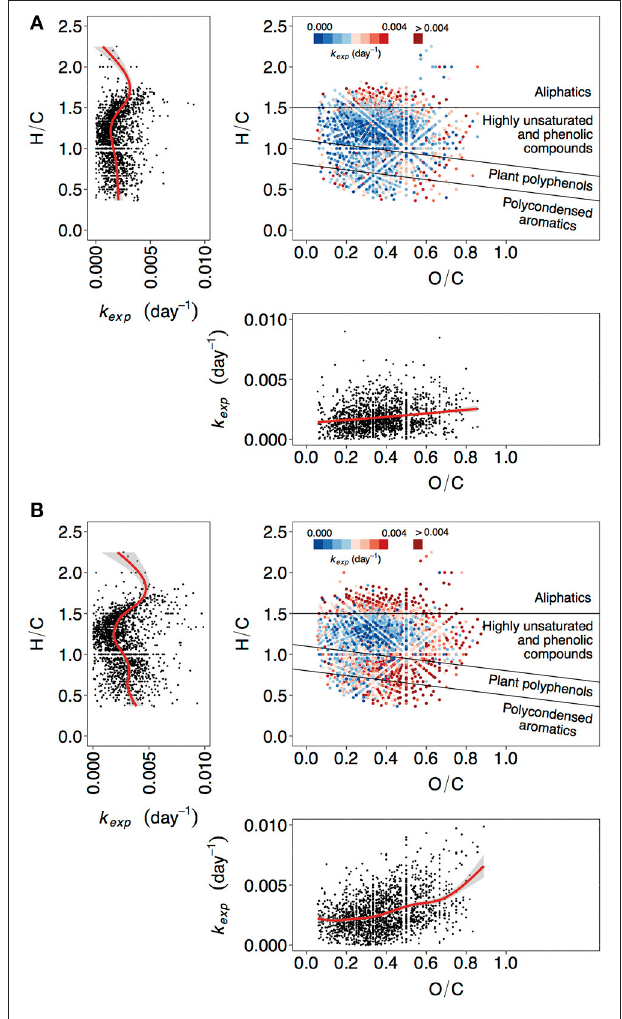
FIGURE 1 | Van Krevelen plots depicting molecular formulae color-coded by value of the decay coefficient k exp . Two additional panels isolate relationship of k exp with H/C (left), and O/C (bottom) ratios. Red lines correspond to fitted generalized additive models (GAM). (A) Lake Ramsjön, non-manipulated treatment, (B) Lake Ramsjön, UV-manipulated treatment. One of the duplicate treatments is shown in each case (two other lakes and all the duplicates are shown in the Figure